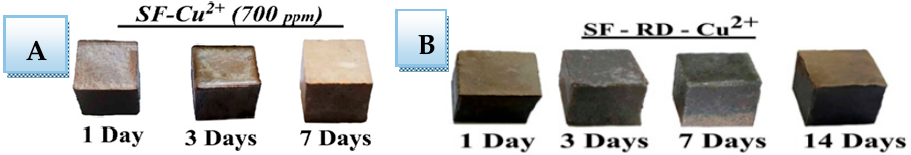
Figure 2. Visual observation of different slag-FA-based geopolymer mixes activated by NaOH and Na 2 SiO 3 after different periods of water curing, ( A ) SF-Cu 2+ and ( B ) SF-RD-Cu 2+ .